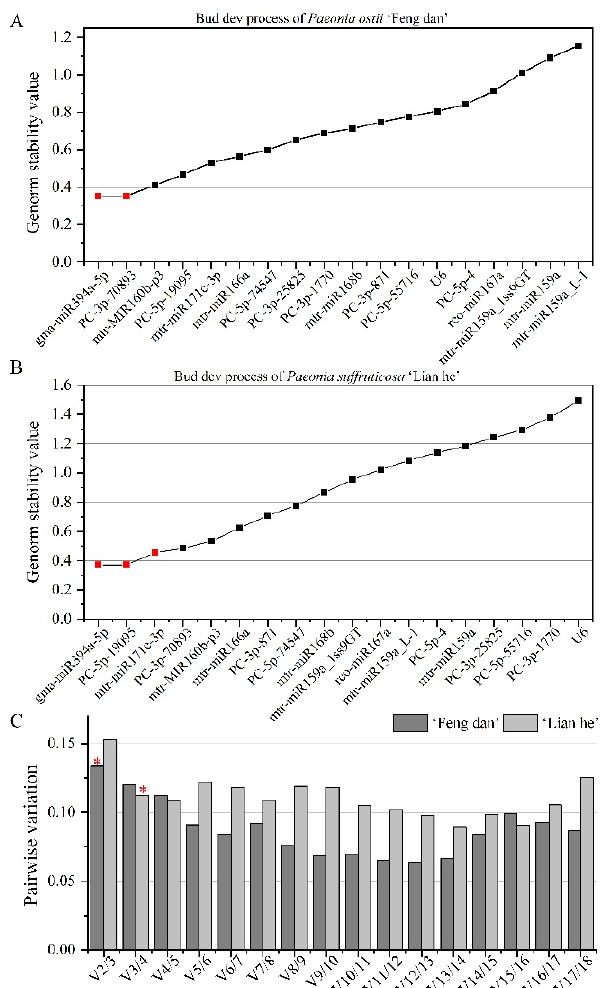
Figure 6. Expression stability analysis and pairwise variation (Vn/Vn+1) analysis of candidate reference miRNAs in bud development process calculated by geNorm. Expression stability results are shown in ( A ) ( Paeonia ostii ‘Feng dan’) and ( B ) ( Paeonia suffruticosa ‘Lian he’) of Figure 6. The most stable miRNA is shown on the left and the least stable miRNA is shown on the right. The red ‘ (cid:4) ’ represents suitable miRNAs. The results of pairwise variation analysis are shown in ( C ). The red ‘*’ represents a suitable quantity.